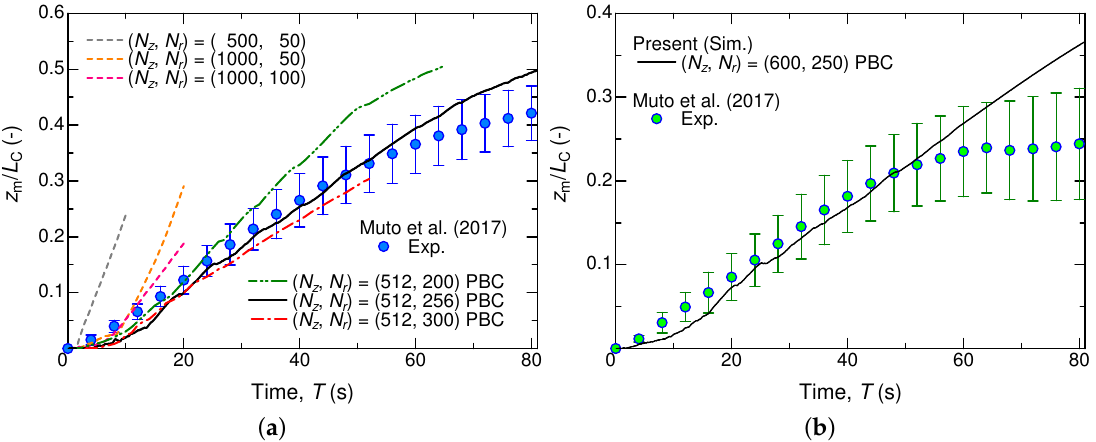
Figure 3. Temporal variations of the migration distance z m of the liquid column normalized by the liquid column length L c , calculated by Equation (20), and comparison with the experimental results [23]. In the legend, ‘PBC’ represents a case with the periodic boundary condition in the z direction. ( a ) L c = 20 mm, ( b ) L c = 30 mm. The tube radius is R = 1.25